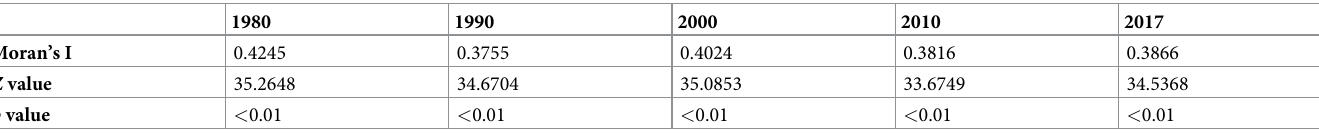
Table 4. A bivariate local spatial autocorrelation analysis of township social demand and potential